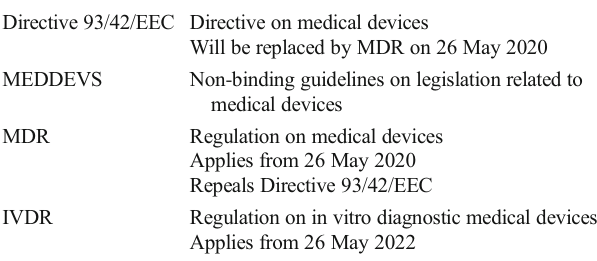
Regulatory framework in the EU on medical